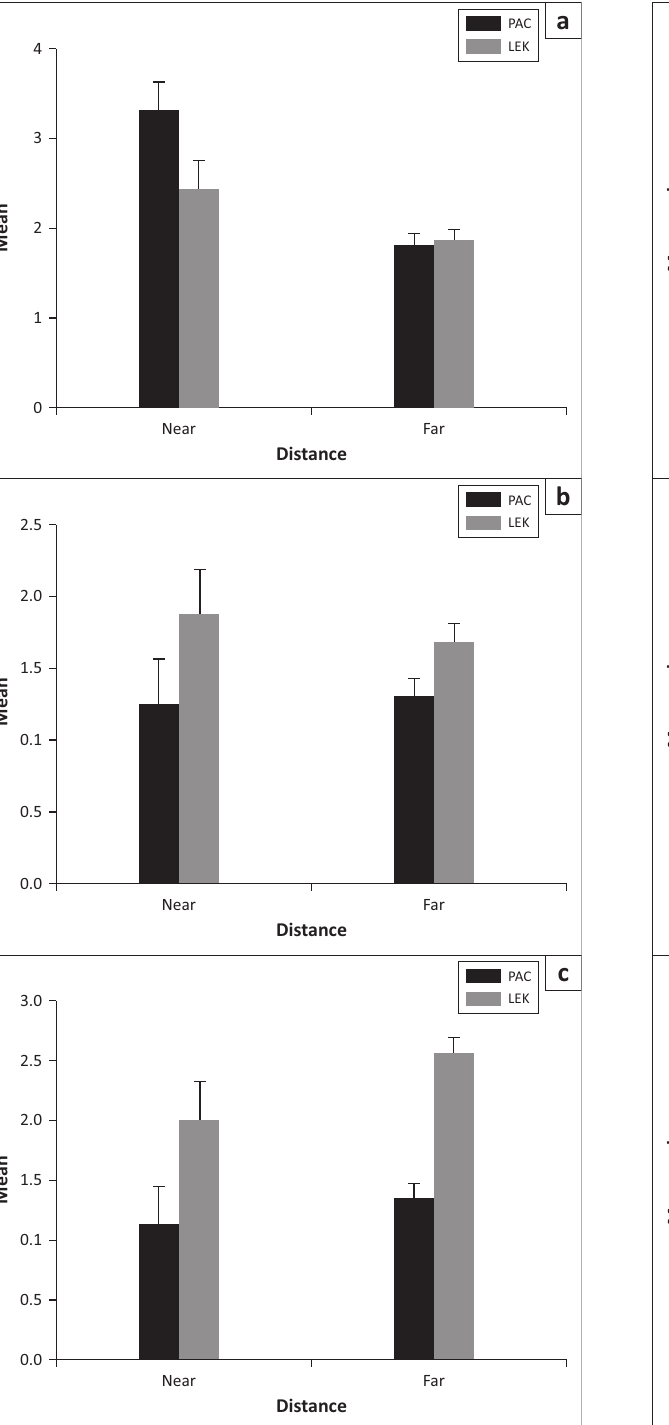
FIGURE 3: Comparison of carnivore predation on livestock incidents between Department of Wildlife and National Parks–confirmed incidents (Problem Animal Control) and herders interviewed (local ecological knowledge). (a) Lion, (b) leopard and (c) wild dog.